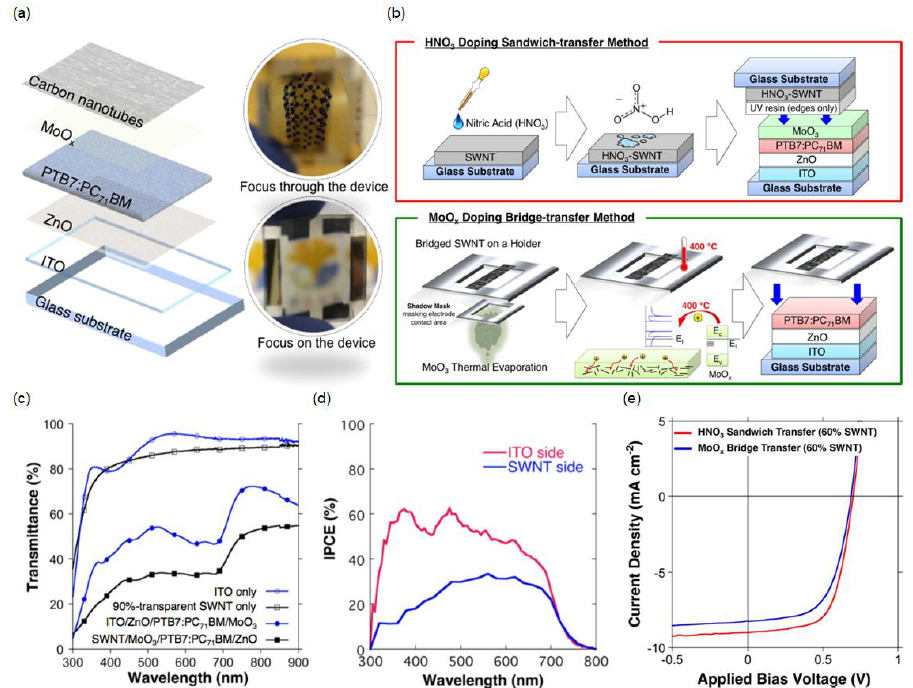
Figure 7. ( a ) Schematic diagram of the SSC with the laminated CNT top electrode (left) and photographs with different foci (right); ( b ) Schematic illustrations of the HNO 3 doping